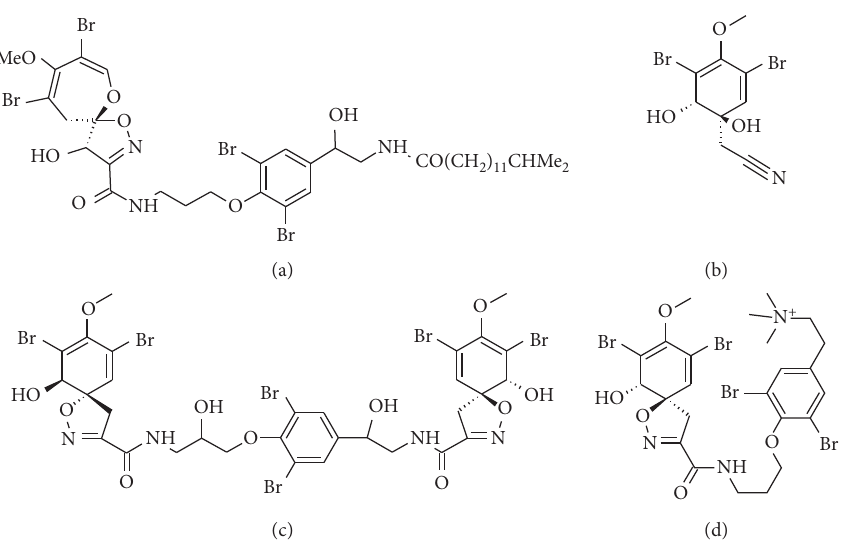
Figure 5: Chemical structure of bromotyrosines with antiviral activity against HIV-1. (a) Psammaplysine D. (b) Purealidin B. (c) Fisturalin- 3. (d)